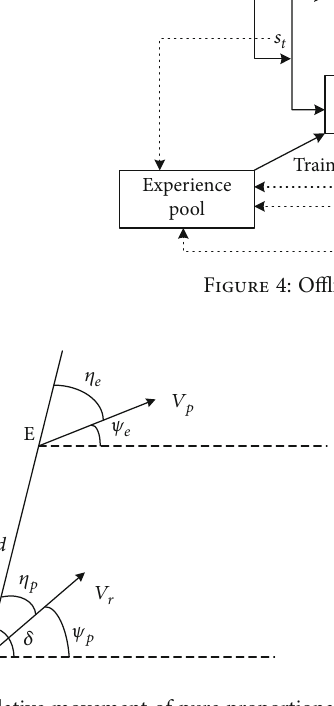
Figure 5: Relative movement of pure proportional method.